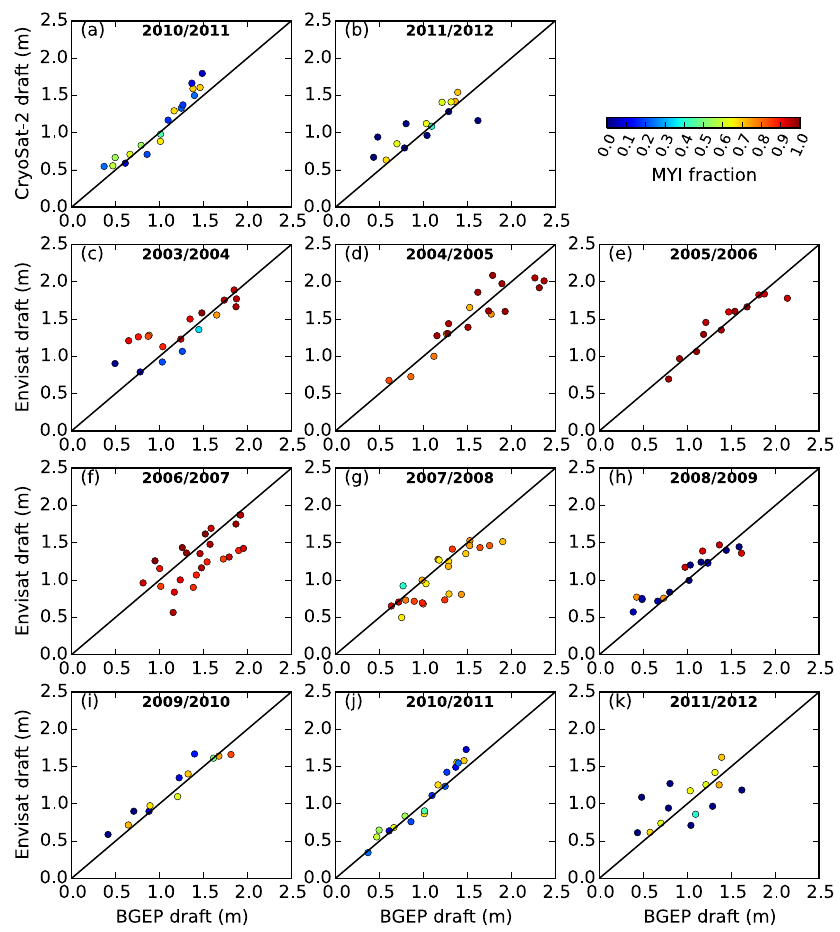
Figure 7. CryoSat-2 monthly ice draught as a function of BGEP moorings monthly median ice draught for winters 2010/11 (a) and 2011/12 (b) . Envisat/PP monthly ice draught as a function of BGEP moorings monthly median ice draught for winters 2003/04 to 2011/12 (c– k) . The colour map shows the corresponding multiyear ice (MYI)